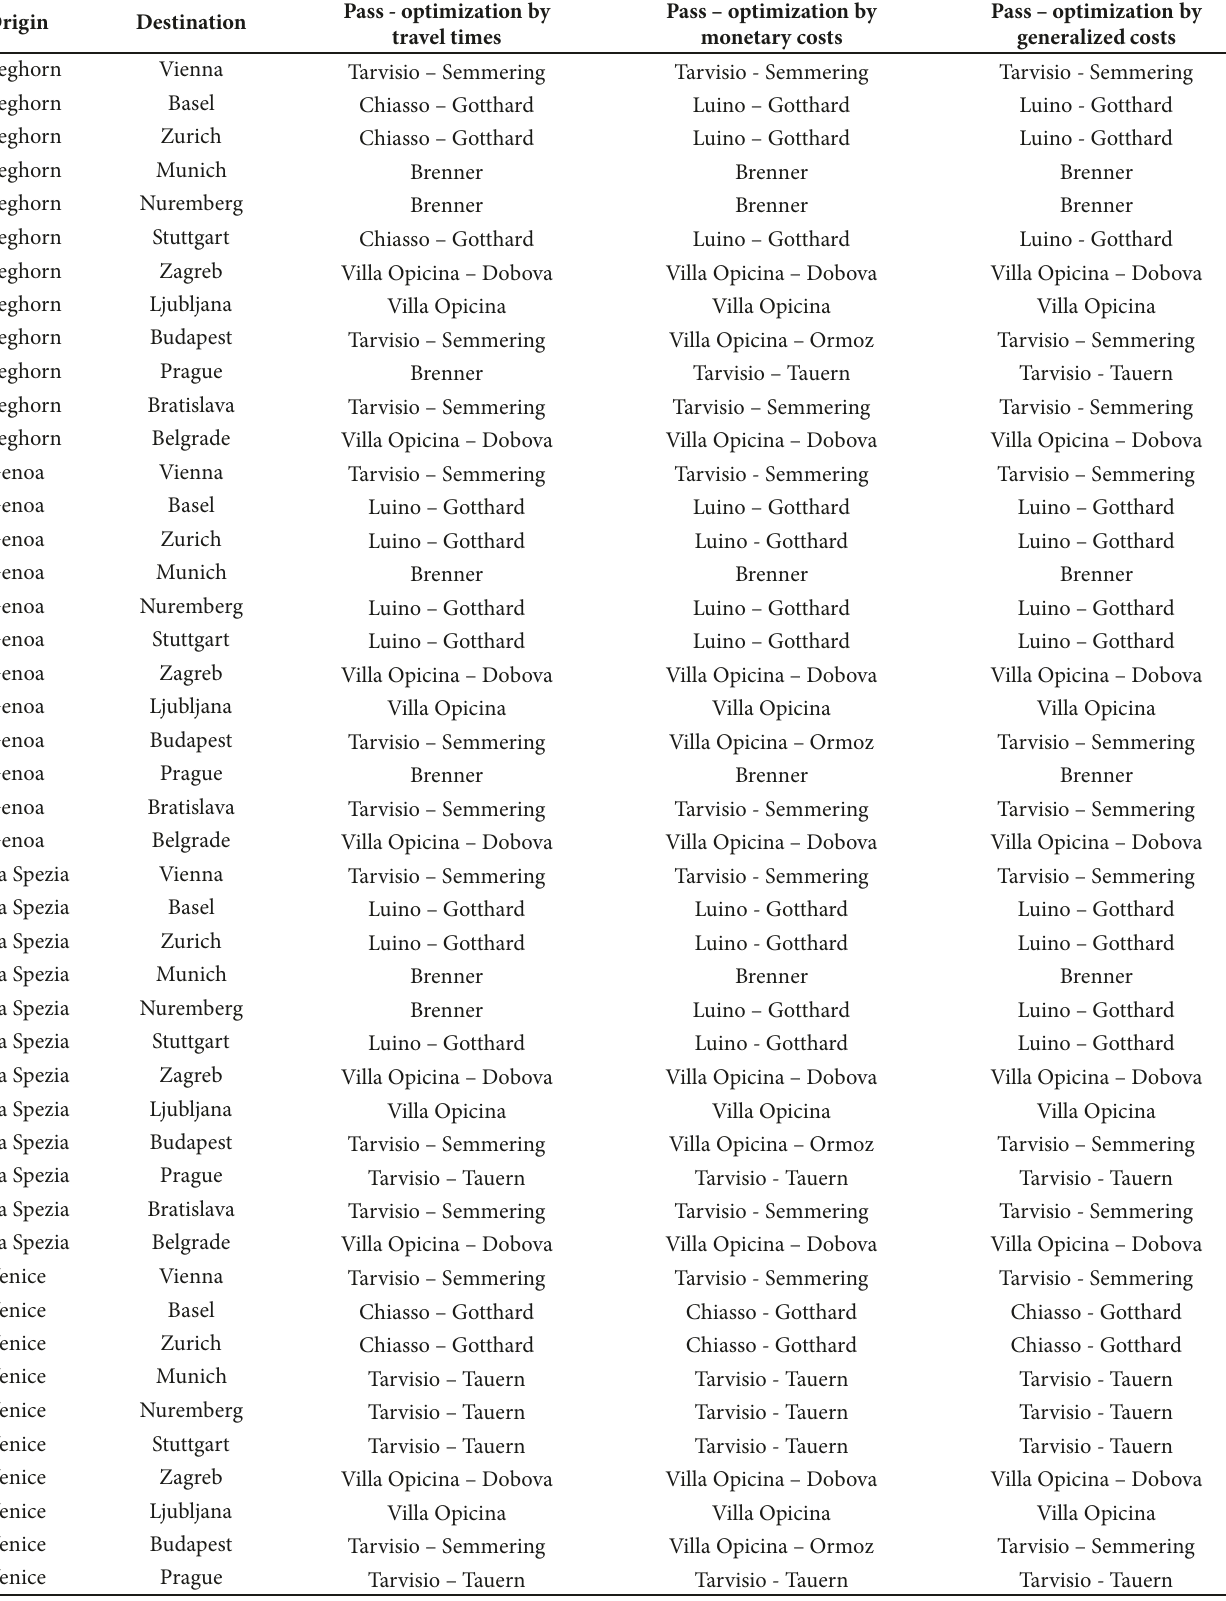
Table 8: Railway lines crossing the Alps used to connect the considered O/D pairs. Only O/D pairs which require the crossing of Alpine passes have been taken into